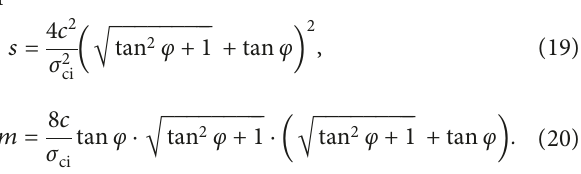
Figure 5: Mohr diagram for the tested specimens at the same plastic shear strain ε ps under different confining pressures